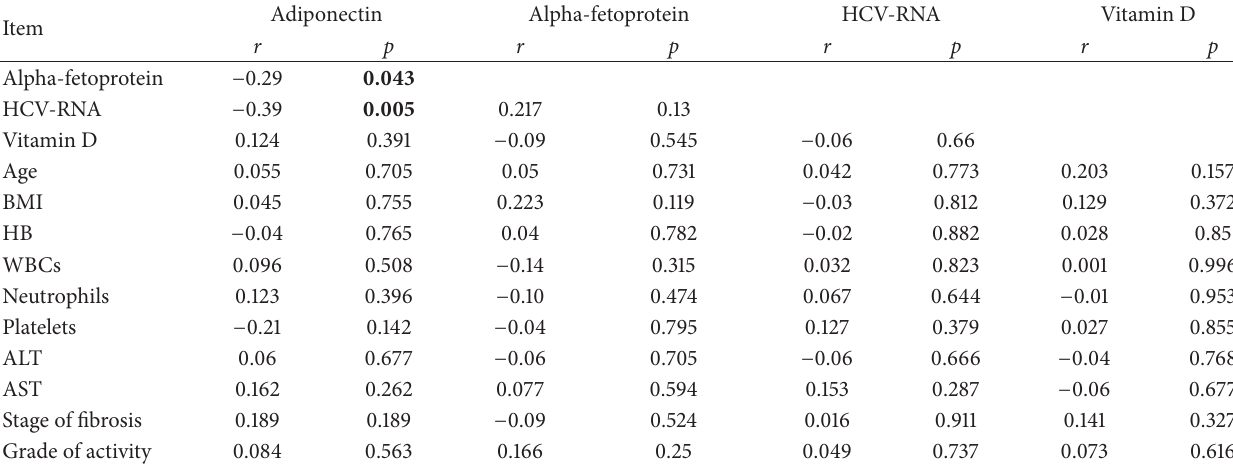
Table 2: Correlation of predictors of treatment response with other studied parameters.